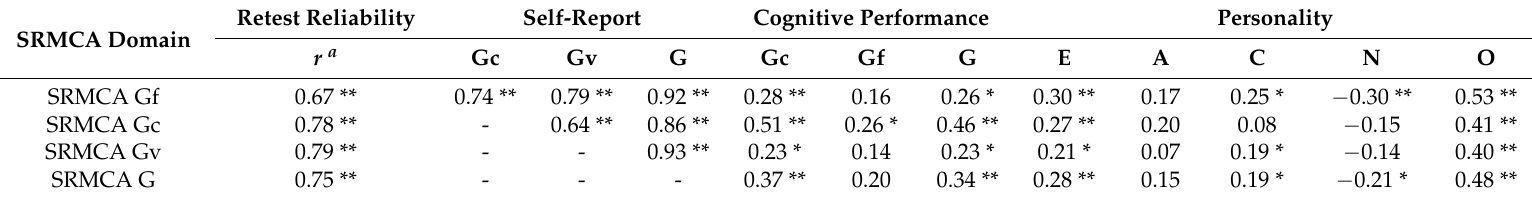
Table 3. Correlations between SRMCA domains, cognitive performance factors and personality traits.